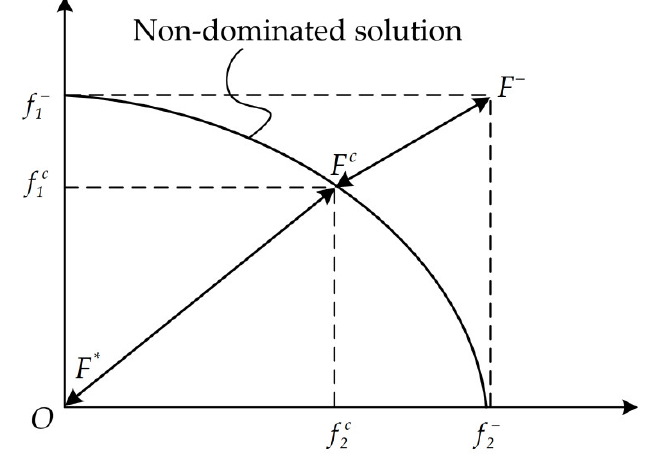
Figure 12. Ideal solution and compromise solutions in the VIKOR method.